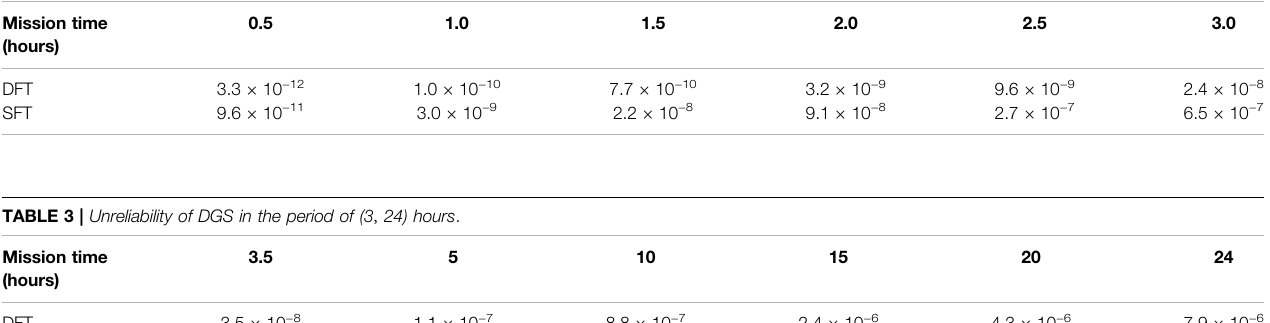
TABLE 2 | Unreliability of DGS in the period of (0, 3) hours.